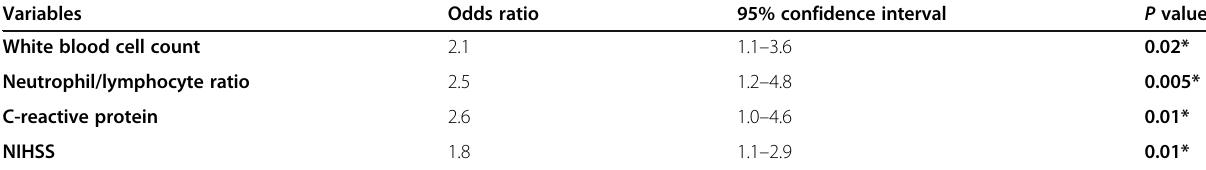
Table 3 Binary logistic regression analysis of the predictors of the unfavorable outcomes of acute ischemic stroke Variables